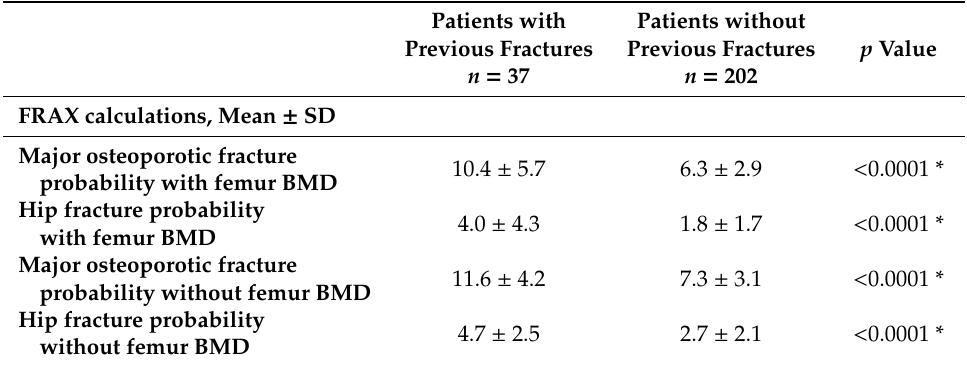
Figure 3. Candidates for pharmacological intervention by the WHO criteria and FRAX criteria. * p < 0.05. Statistical analysis was performed using McNemar’s test. WHO, World Health Organization; FRAX, Fracture risk assessment tool; OA, osteoarthritis; BMD, bone mineral density. Table 4. Comparison of 10-year fracture probabilities calculated using the FRAX for the patients with or without previous fractures among the patients with knee